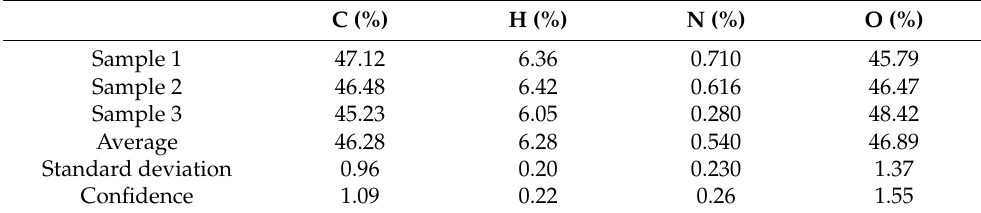
Table 2. Elemental analysis